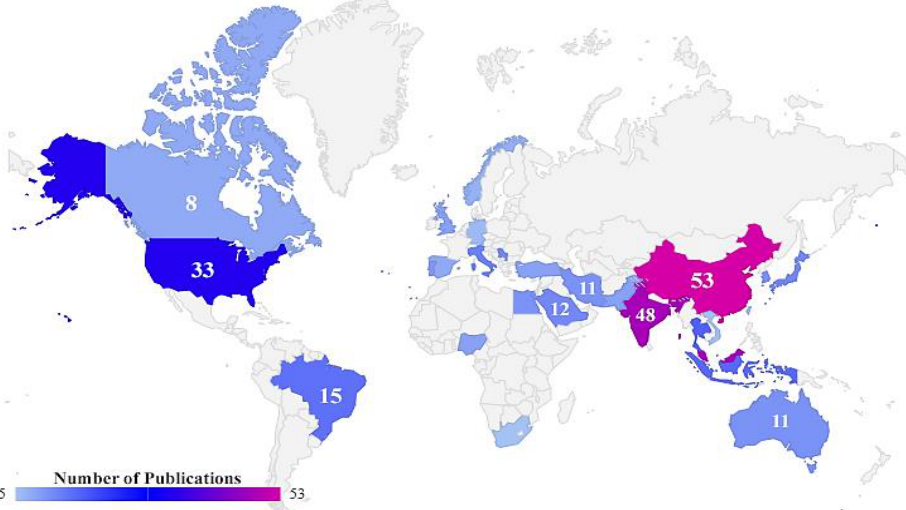
Figure 3. Representation of the distribution of articles by country.